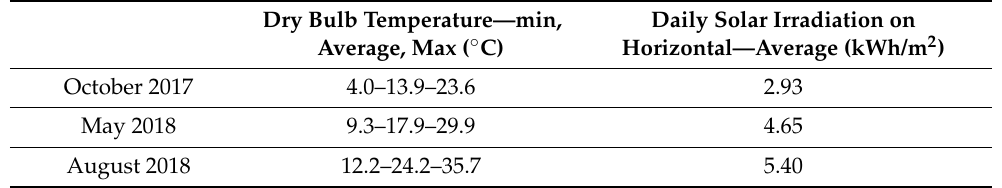
Table 4. Climatic parameters in the calibration month (October 2017) and in the validation ones (May and August 2018) for the case study.